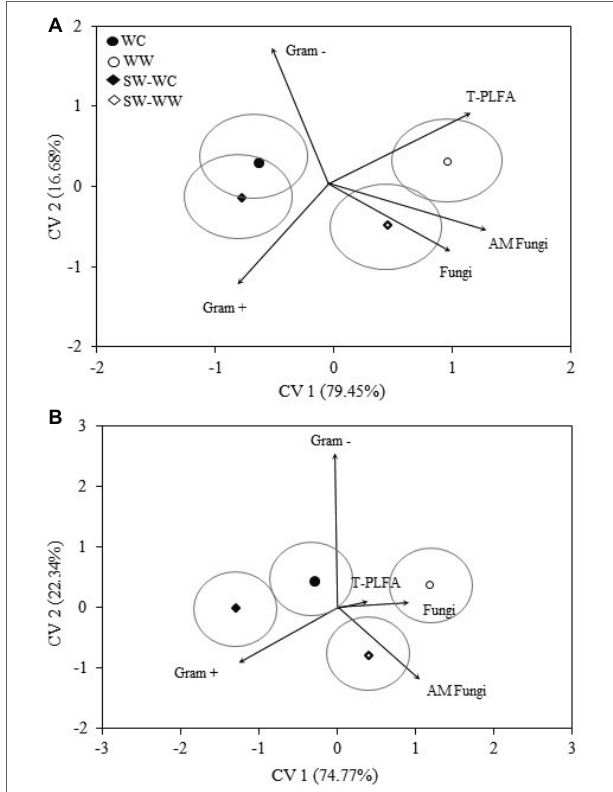
FIGURE 2 | Canonical variates for lipid biomarker groups. Biomarker groups and total PLFA (T-PLFA) for 0–5 (A) and 5–10 (B) cm depths from crop years 2009 to 2014. Vectors represent standardized canonical coefficients and indicate the contribution of each biomarker group to each canonical variate. Each point represents the group centroid mean and is accompanied by a mean ellipse at the 95% confidence interval (treatments groups that differ significantly have confidence ellipses that do not intersect).